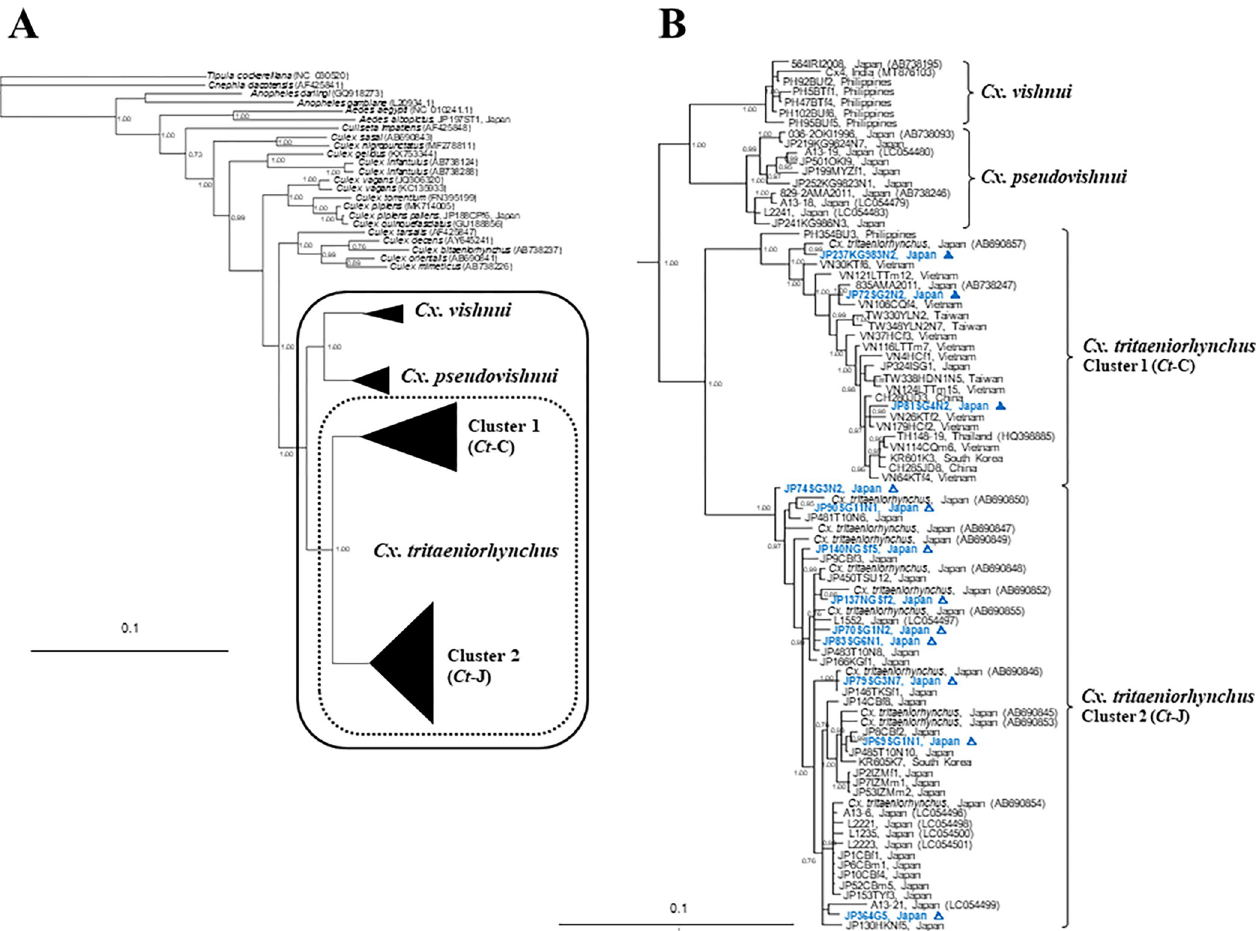
Fig 1. Bayesian inference of a phylogenetic tree based on the nucleotide sequences of the mitochondrial COI region (1542 bp) of 69 Cx . tritaeniorhynchus specimens. A: Summarized Bayesian phylogenetic tree with 86 COI sequences of Cx . vishnui subgroup and 23 sequences as an outgroup. The black frame indicates Cx . vishnui subgroup, and the dotted frame indicates Cx . tritaeniorhynchus . B: Expanded subtree of 86 COI sequences of Cx . vishnui subgroup. Bootstrap values correspond to 1000 replications. Bar denotes the nucleotide similarity distance. GenBank accession numbers for sequences used in the phylogenetic analysis are in S1 Table. Open and closed triangles with blue indicate Ct -J and Ct -C subtypes of the Cx . tritaeniorhynchus specimens, respectively, captured in net-traps (NTs) and a Johnson-Taylor suction trap (JT-ST).